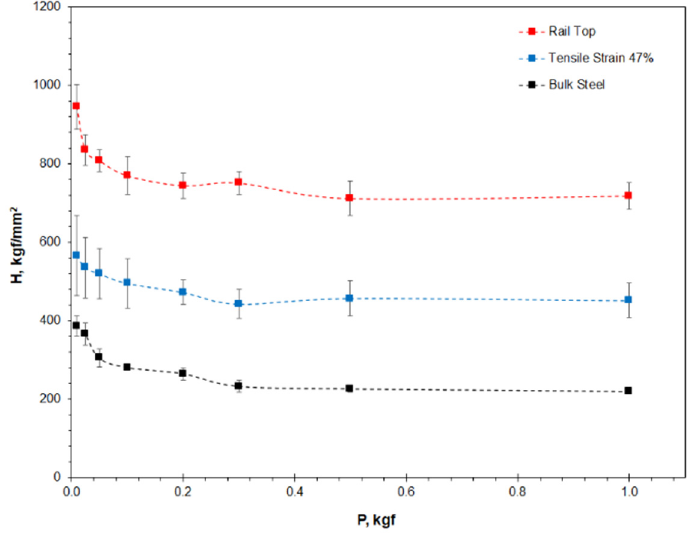
Figure 4. The microhardness properties of the three Hadfield steel samples plotted versus the applied indentation load. Table 2. The average hardness and deviation of the three Hadfield steel samples measured at various